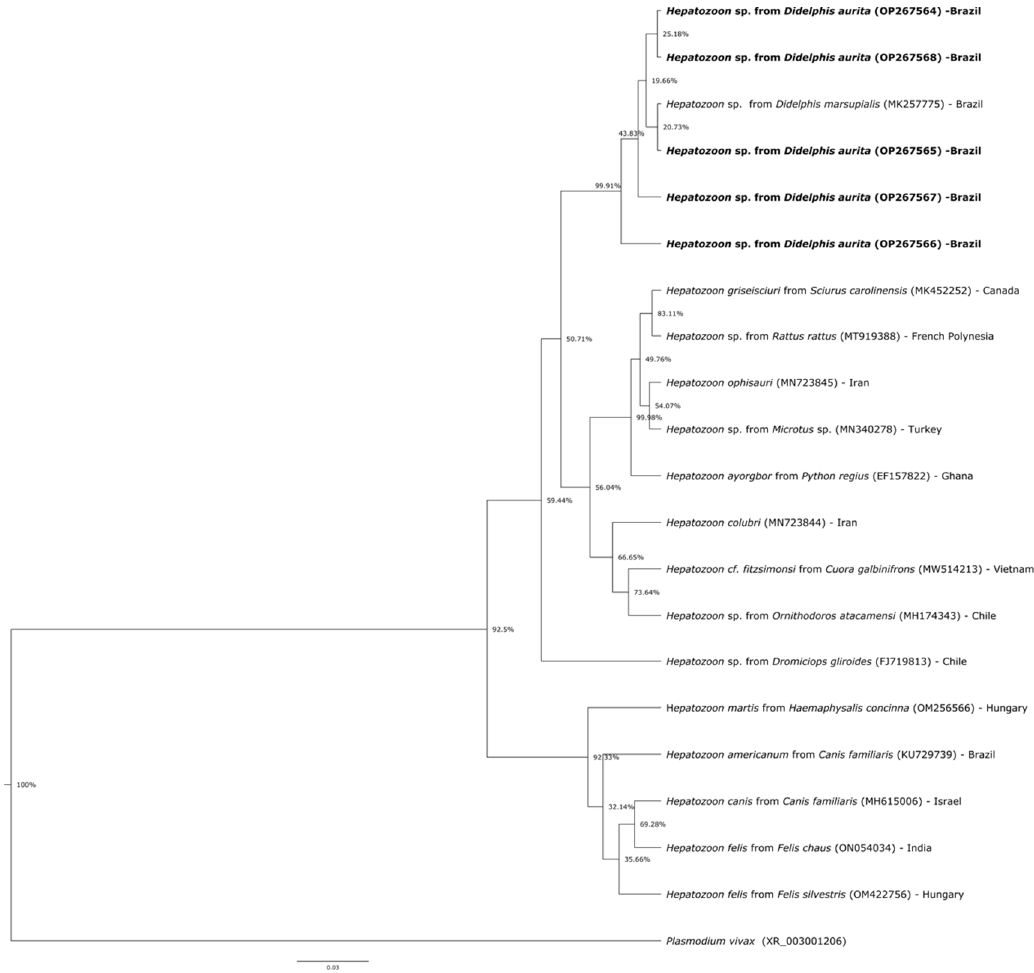
Figure 6. Phylogenetic tree based on partial sequences of the 18S rRNA gene (740 bp), showing the relationship between the Hepatozoon sp. detected in the black-eared opossums ( Didelphis aurita ) from this study and other Hepatozoon species. Mycoplasma pneumoniae was used as outgroup. The GenBank accession number is in parentheses after the species name and origin of each agent. Bayesian inferences were carried out applying the GTR + I + G model and 1000 bootstrap replicates for all analyses. Table 2. Significant differences * ( p < 0.05) in the concentration of some of the analytes evaluated of D. aurita with hemoplasma